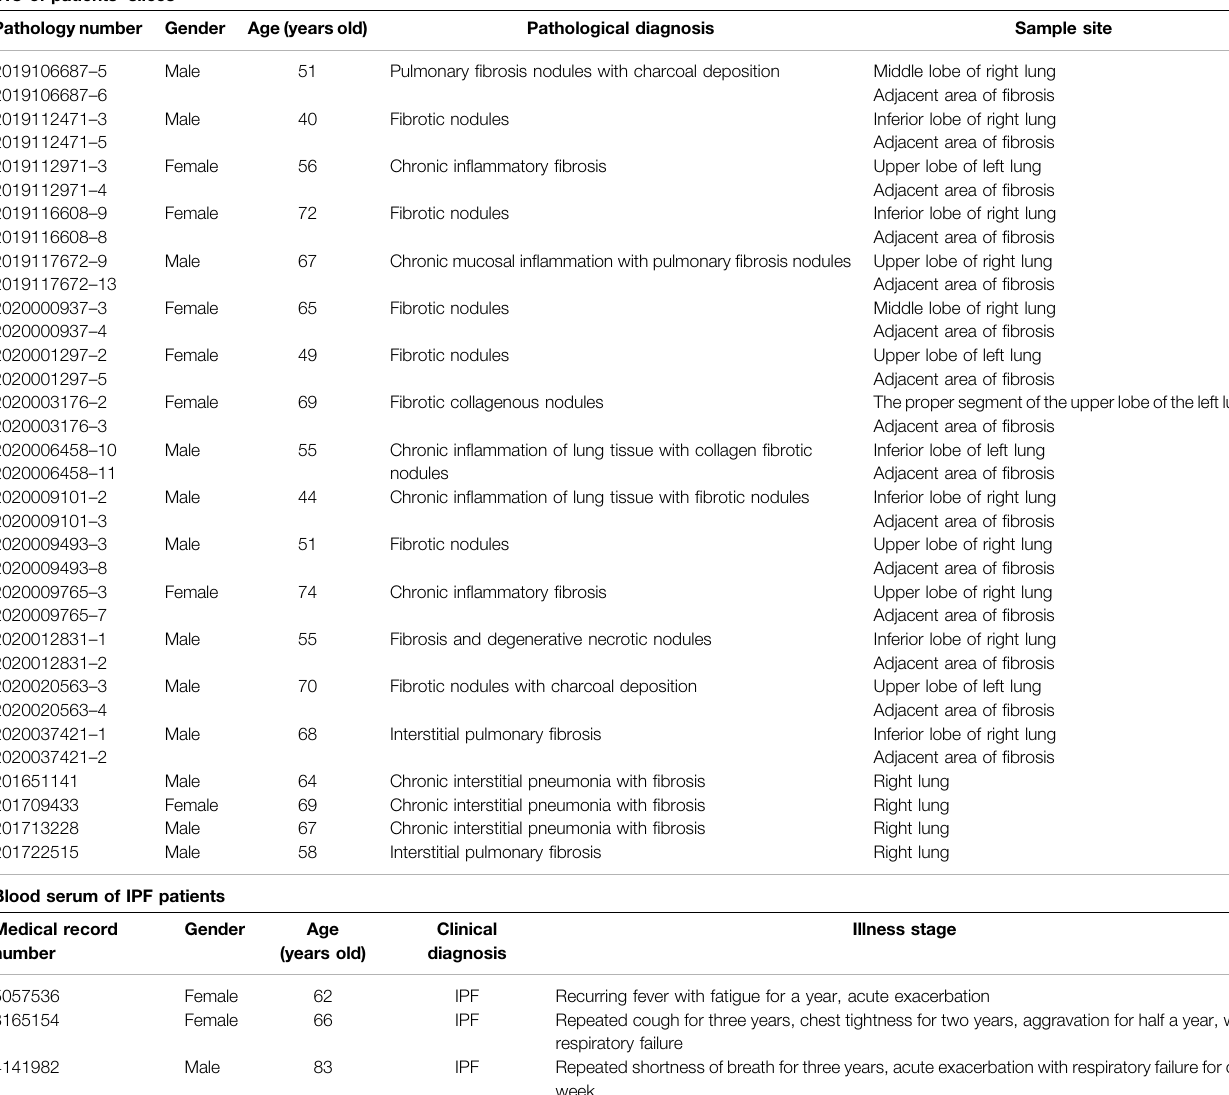
TABLE 3 | Patients ’ information of IPF and other types of pulmonary fi brosis. IHC of patients ’ slices Pathology number Gender